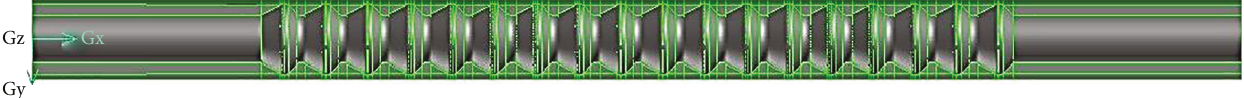
Figure 1: Geometric structure of streamlined partially pressured injection tool.